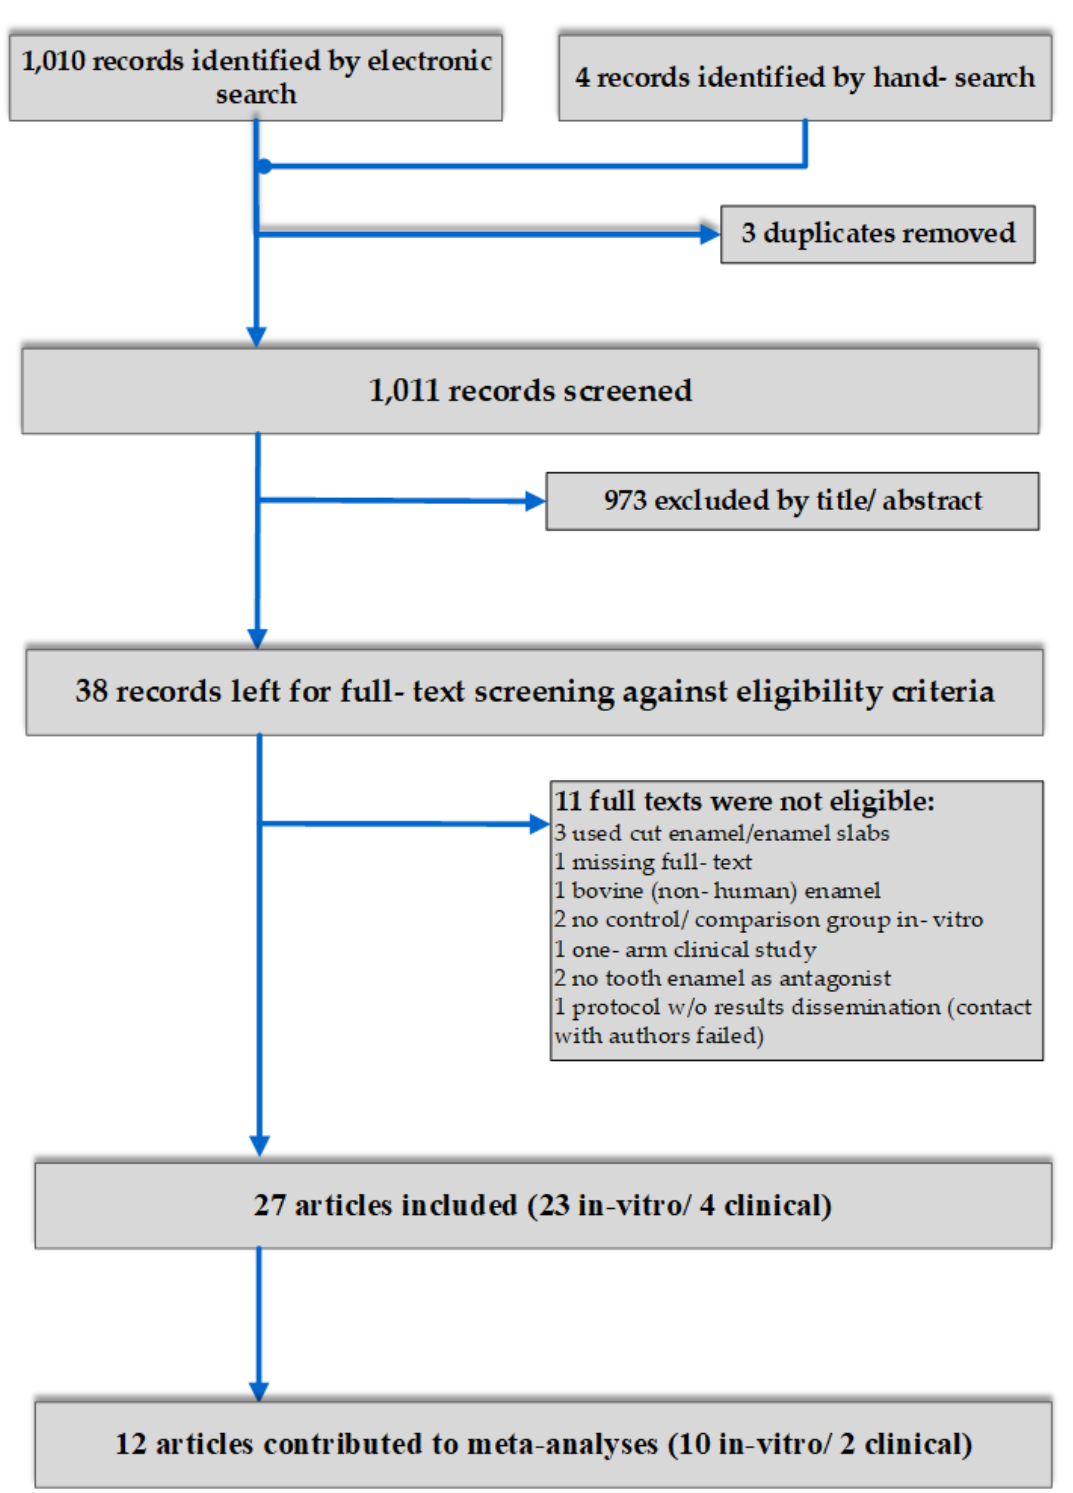
Figure 1. Flow diagram of the article selection.